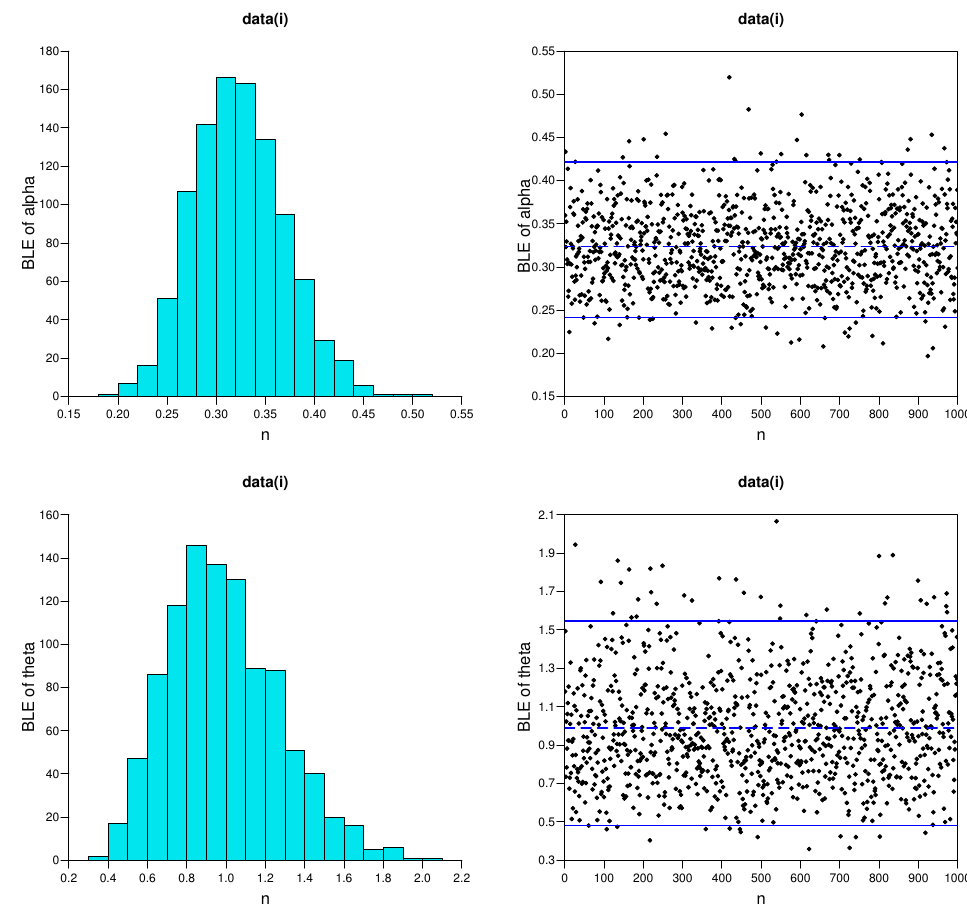
Figure 6. Trace plots (the posterior mean (dashed line) with 95% credible intervals (solid lines)) and corresponding histograms of BLEs of α and θ for data set I.